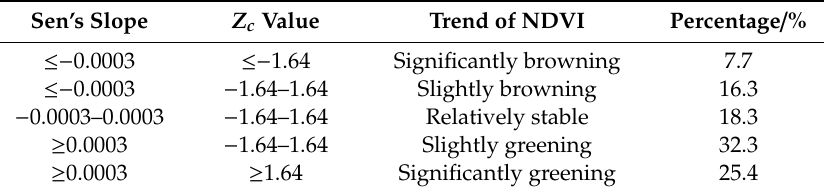
Figure 4. The spatial pattern of Sen’s slope ( a ), Z c value ( b ), and variation trend ( c ) of the growing season NDVI in the YZR basin. season NDVI in the YZR basin. Table 1. Statistics of the growing season NDVI variation Table 1. Statistics of the growing season NDVI variation trend.